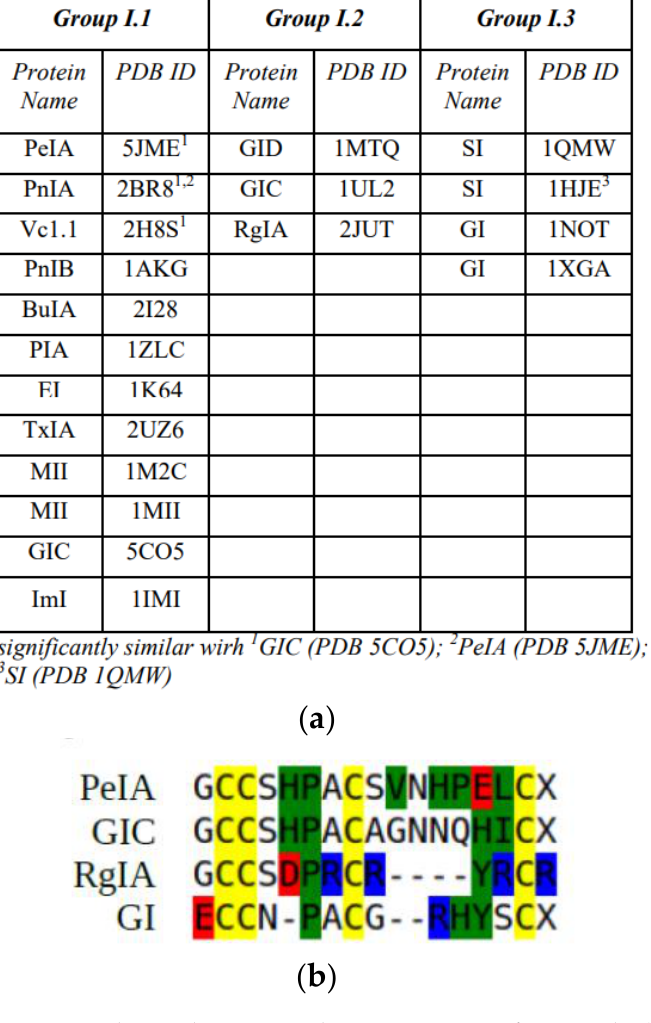
Figure A3. Three subgroups in the type I cysteine framework: ( a ) table summary of the three subgroups with their PDB IDs; ( b ) sequence alignment of the amino acid residues representative of the three subgroups. Adapted from [11].